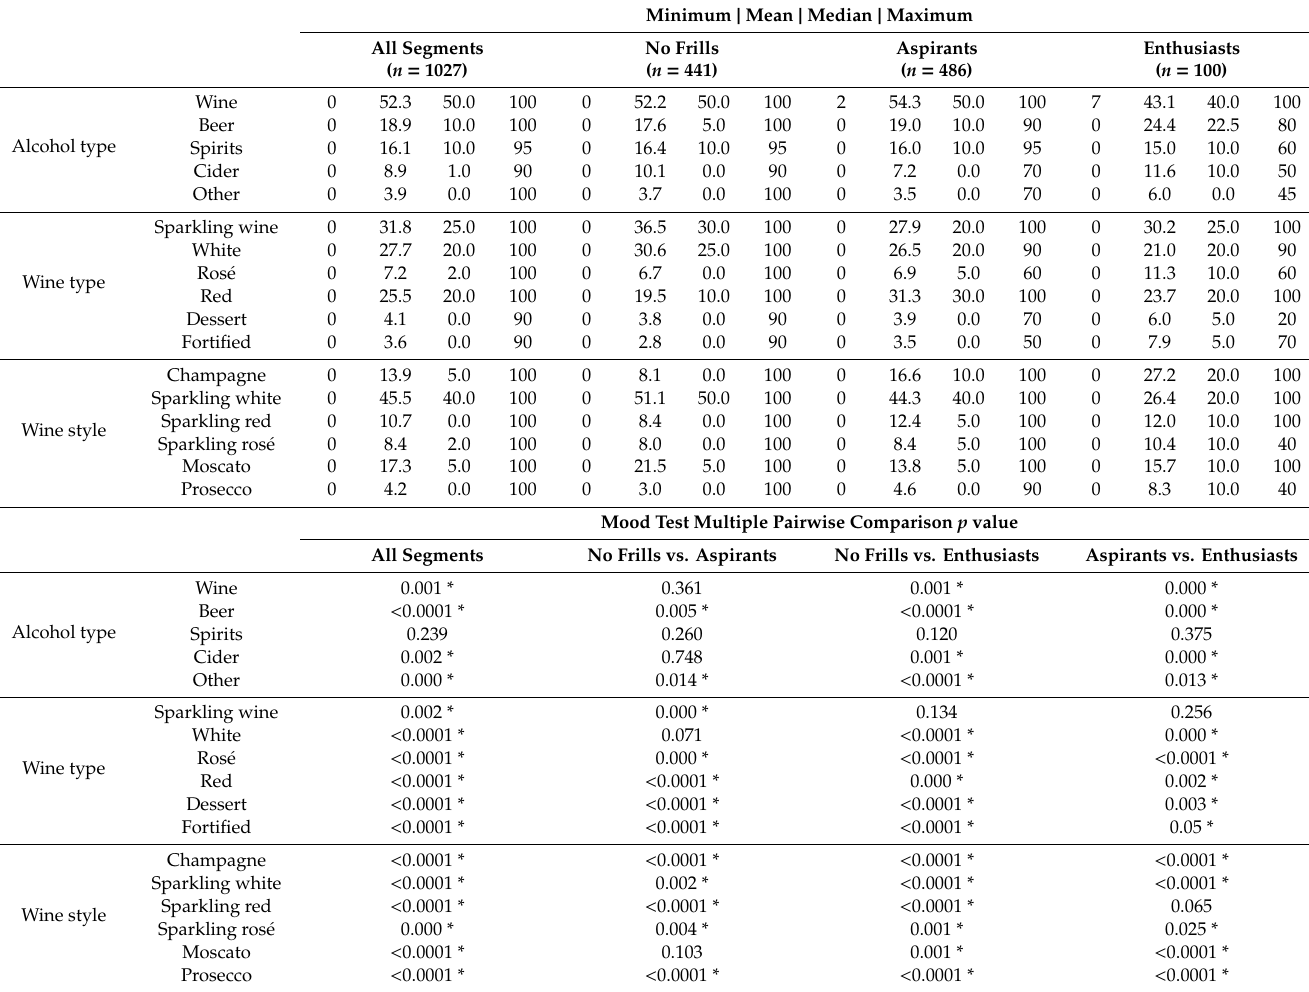
Table 2. Average alcohol, wine and sparkling wine consumption of Fine Wine Instrument consumer